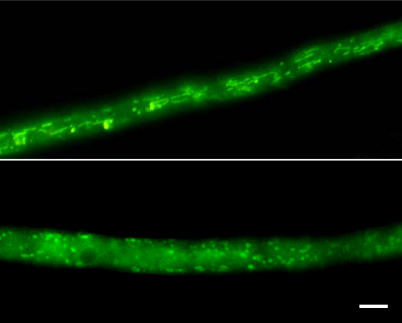
Effect of GR24 on Mitochondrial Shape and Density in Hyphae of
Gi. rosea Stained with Mitotracker Green
Hyphae were treated with 30 nM GR24 (up) or with 0.001% acetone (bottom) for 1 h. Bar = 10 μm.